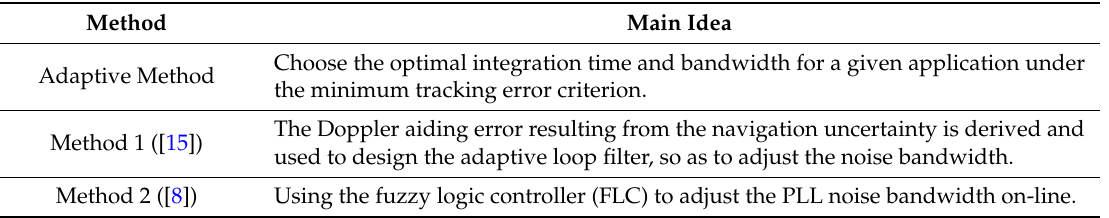
Table 1. The comparison of three improvement tracking methods for INS-aided PLL.